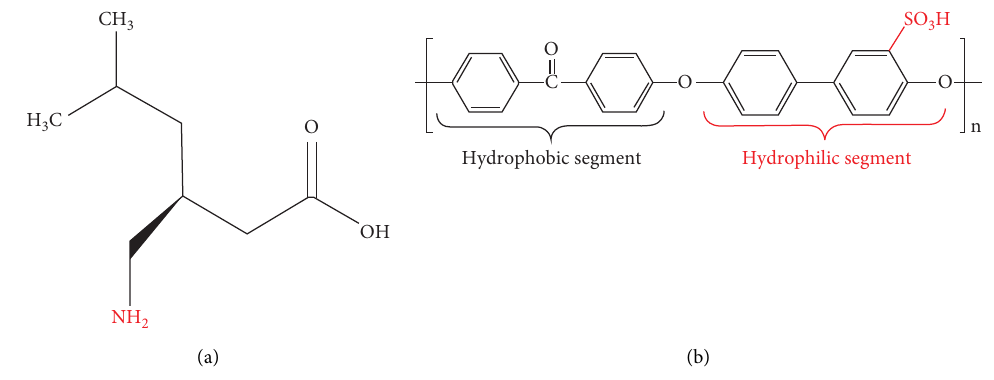
Figure 1: Chemical structure of (a) pregabalin and (b)